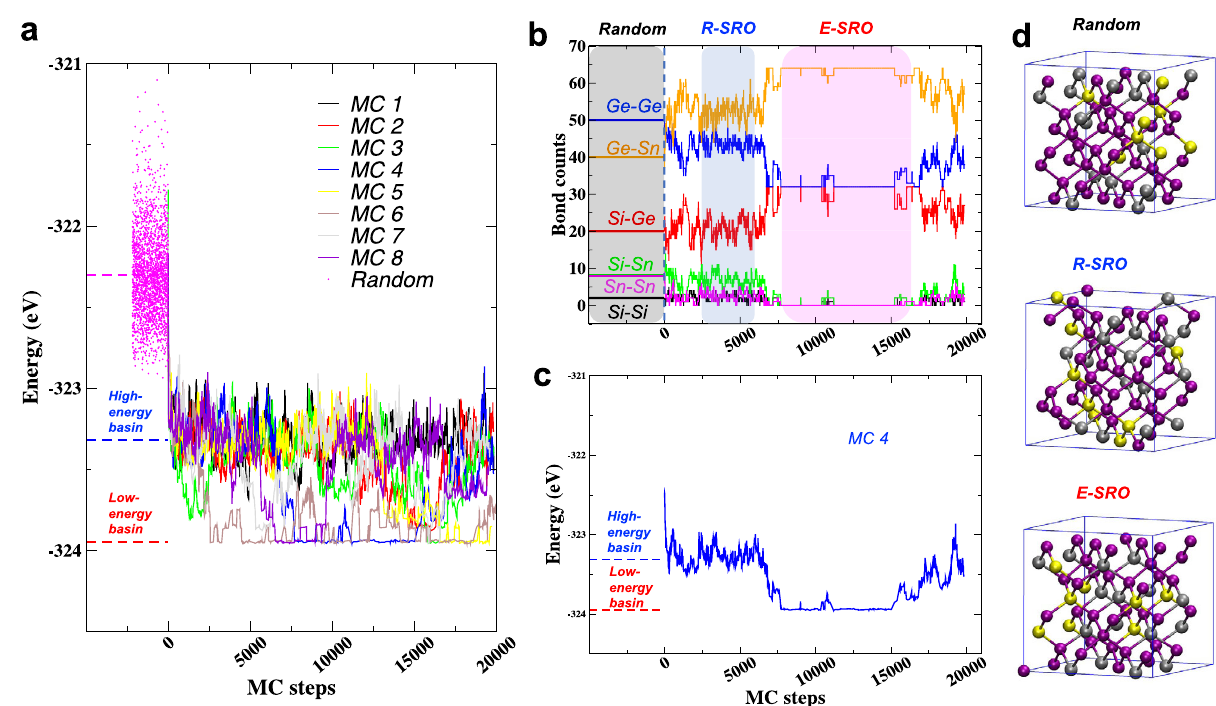
Fig. 1 Variation of energy and structure due to different types of SROs in Si 0.125 Ge 0.625 Sn 0.25 . a The overlay of eight independent MC/DFT trajectories shows the total energy fl uctuates around two well-de fi ned energy levels: the high-energy basin (blue dashed line) and the low-energy basin (red dashed line) that are separated by ~0.6 eV. Both are well below the average energy (magenta dashed line) from random sampling (magenta dots). For clarity, the energy variation of MC 4 is shown separately in ( c ). In accordance, b displays the corresponding variation of bond counts for each type of nearest neighbors. For a truly random distribution, the number of each type of bond with a 64-atom cell (denoted by the horizontal solid lines within the gray- shaded area) is determined only by the overall alloy composition. R-SRO leads to a different combination of six types of bonds (blue-shaded area), yielding a deviation from a random distribution, whereas E-SRO (magenta-shaded area) enhances such deviation. d The atomic con fi gurations of random, R-SRO, and E-SRO structures obtained from MC 4. Si, Ge, and Sn atoms are represented by yellow, purple, and silver,